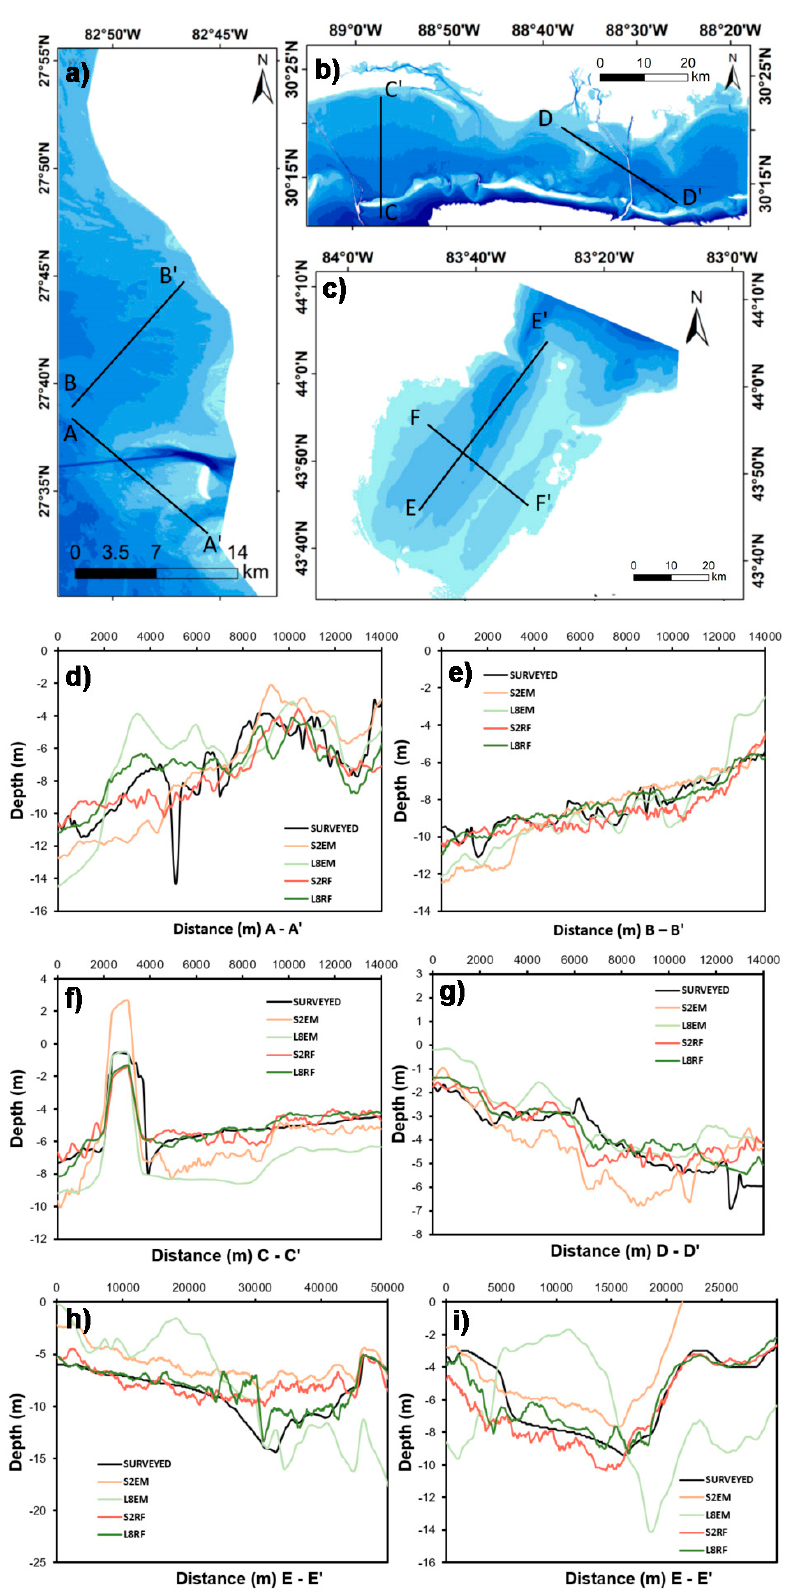
Figure 11. Bathymetric profiles extracted from the empirical and random forest models using Sentinel-2 and Landsat-8 images for Tampa Bay ( a , d , e ), Mobile Bay ( b , f , g ), and Lake Huron ( c , h , i ).